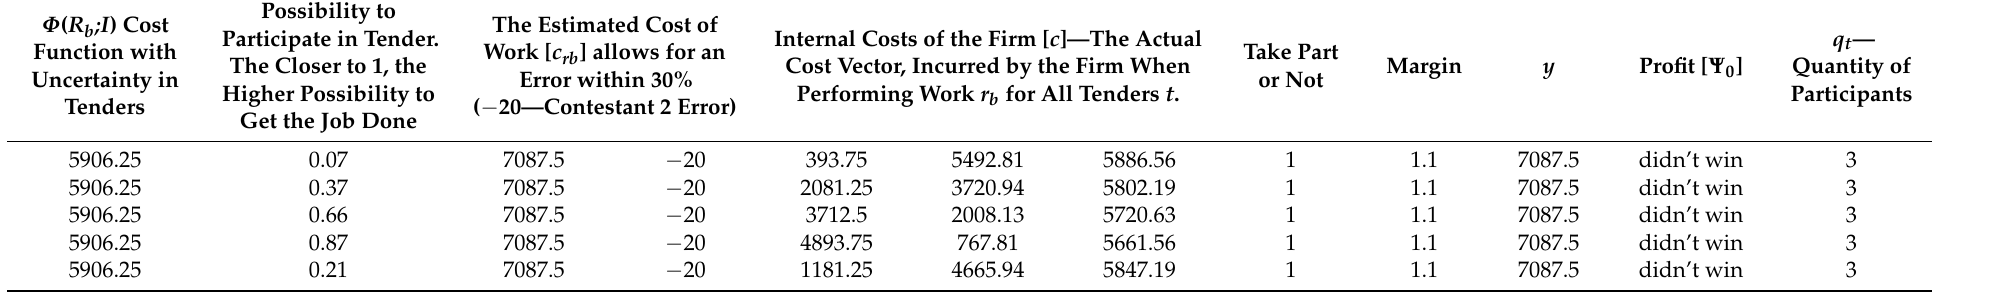
Table 5. Fragment of the spreadsheet list “Contestant 2 Behavior